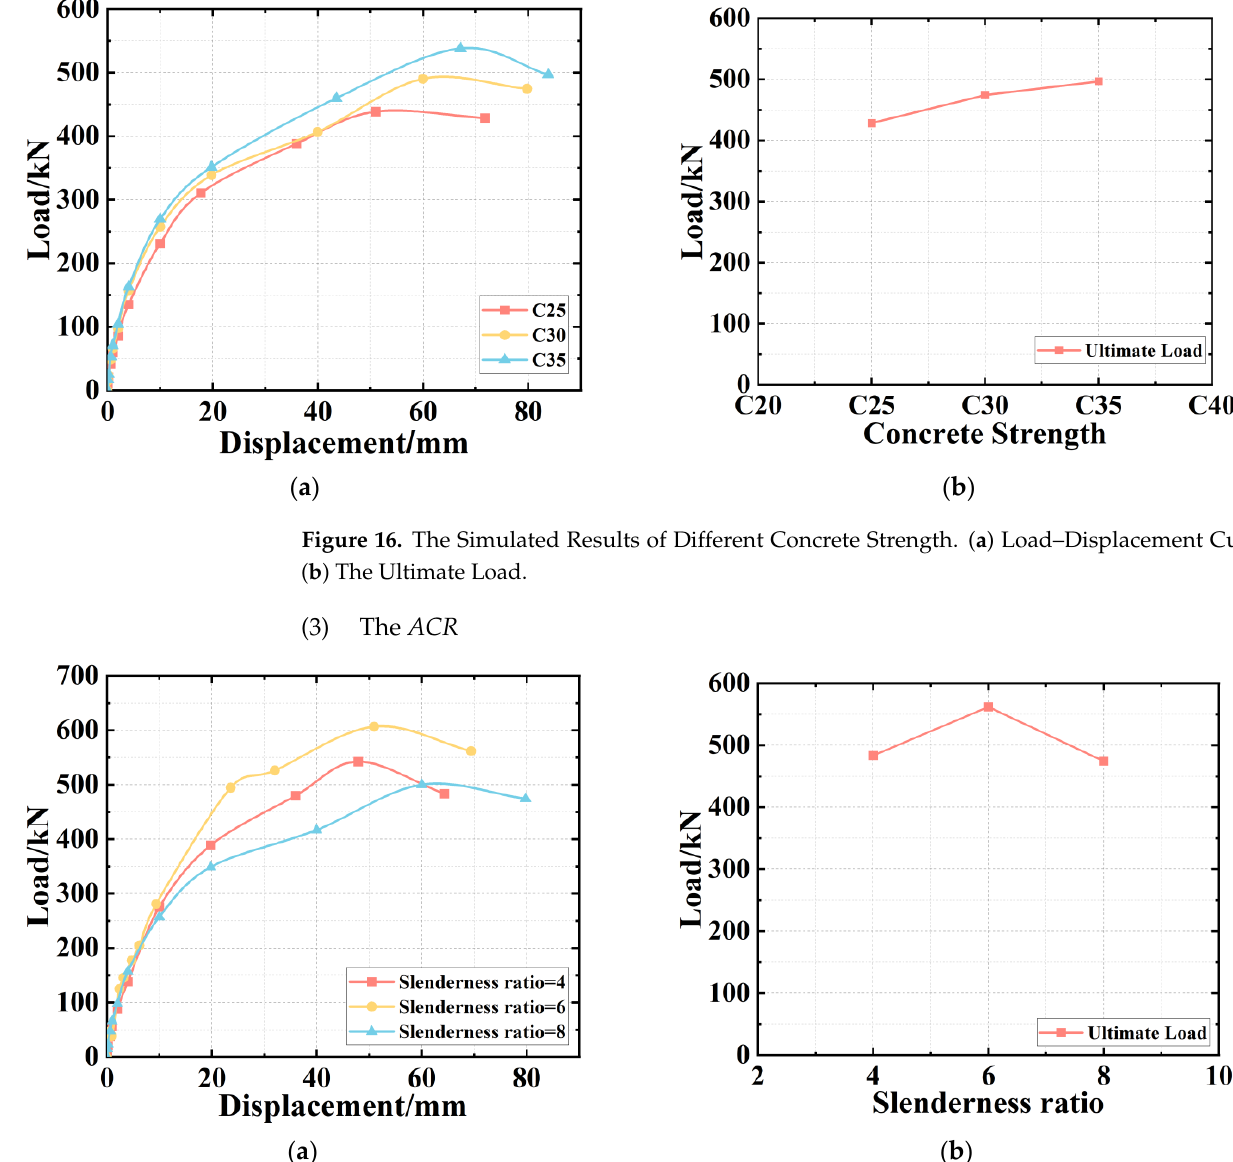
Figure 16. The Simulated Results of Different Concrete Strength. ( a ) Load – Displacement Curves. ( b ) The Ultimate Load.